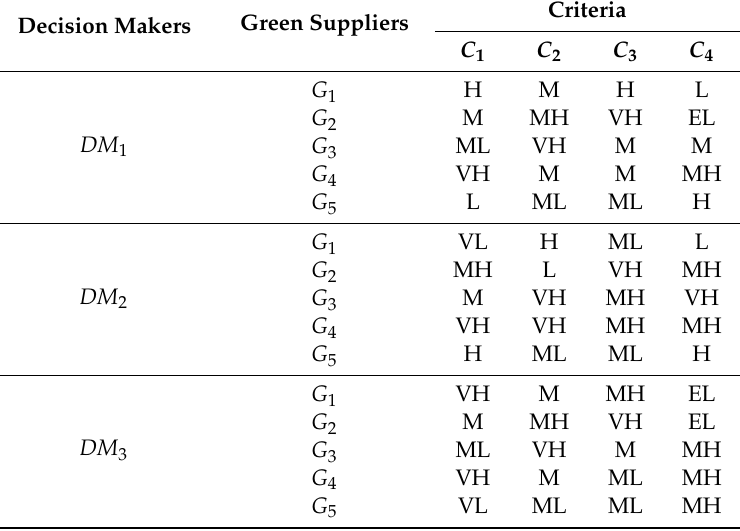
Table 2. Linguistic terms of decision